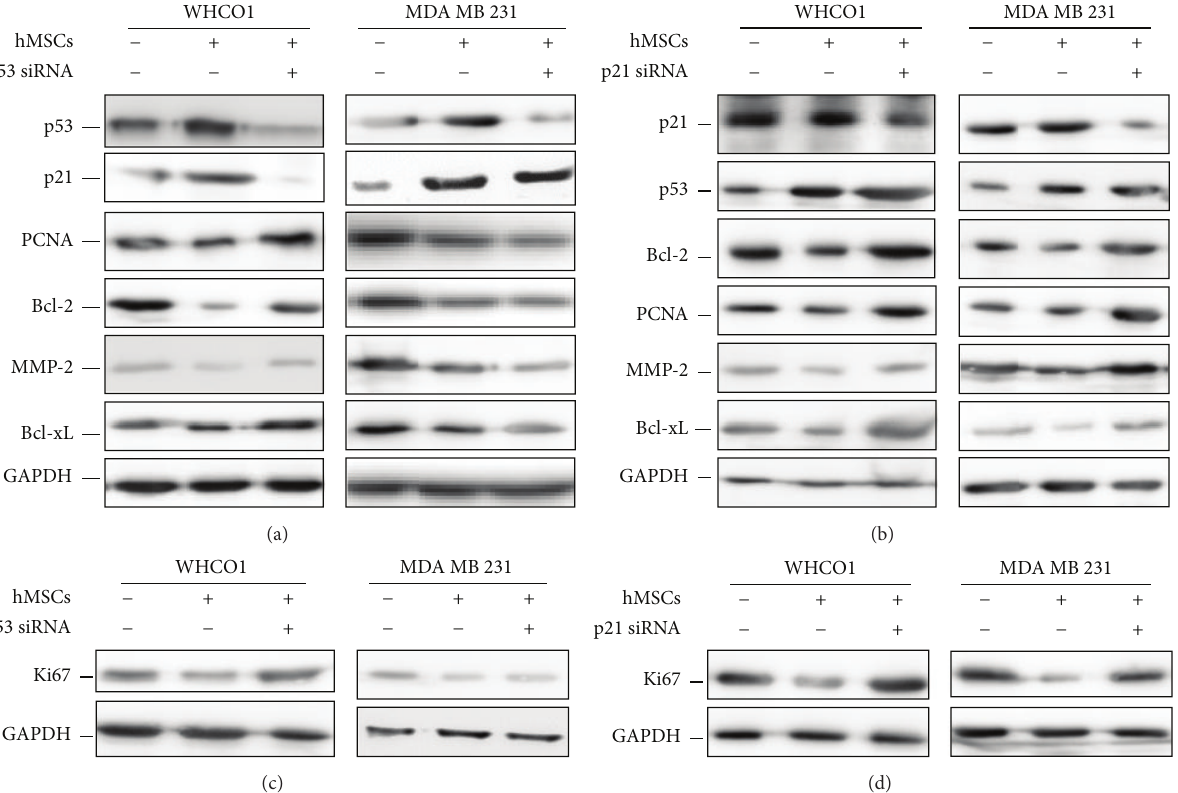
Figure 5: MSCs and matrix-mediated downregulation of WHCO1 and MDA MB 231 cellular gene expression occurs via a p21 pathway. (a) Western blot analysis of lysates from WHCO1 and MDA MB 231 cells cocultured with MSCs and transfected with p53 siRNA for 48 hrs showing expression of p53, p21, PCNA, Bcl-2, MMP-2, and Bcl-xL. (b) Western blot analysis of lysates from WHCO1 and MDA MB 231 cells cocultured with MSCs and transfected with p21 siRNA for 48 hrs showing expression of the same genes as in (a). (c) Western blot analysis of lysates from WHCO1 and MDA MB 231 cells cocultured with MSCs and transfected with p53 siRNA for 48 hrs showing expression of Ki67. (d) Western blot analysis of lysates from WHCO1 and MDA MB 231 cells cocultured with MSCs and transfected with p21 siRNA for 48 hrs showing expression of Ki67. Glyceraldehyde 3-phosphate dehydrogenase (GAPDH) was used as a loading